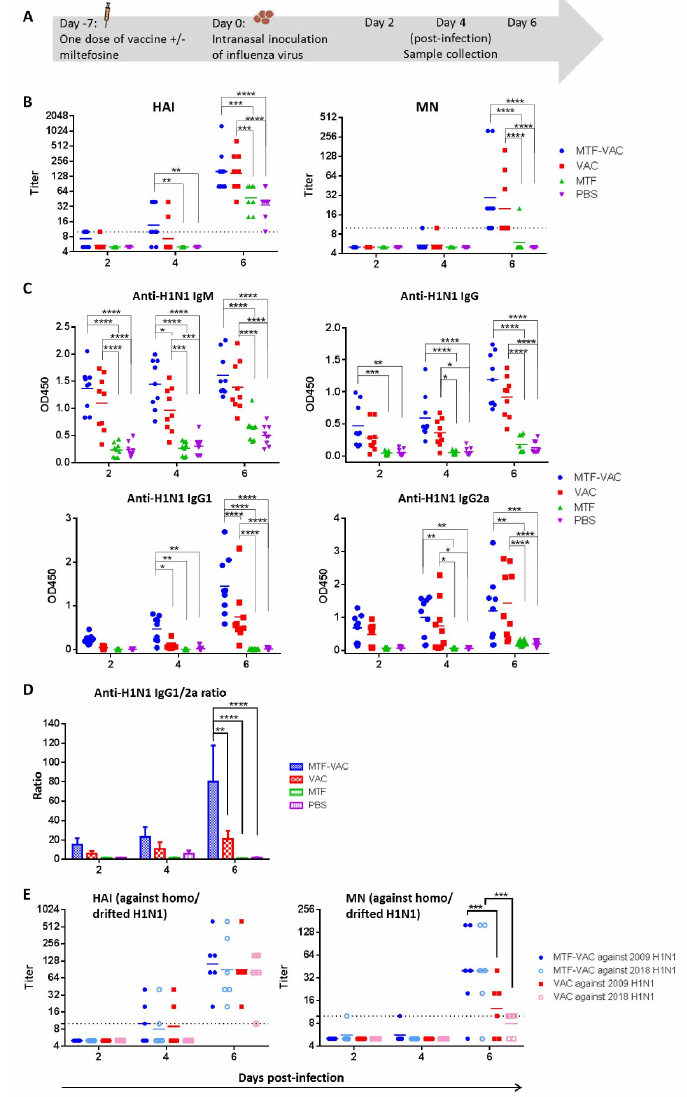
Figure 2. The effect of a single dose of vaccine with or without miltefosine on the antibody titers administrated 7 days before influenza virus challenge. ( A ) Schedule of influenza vaccination, virus challenge, and sample collection. ( B ) Hemagglutination inhibition assay (HAI) titers and micro-neutralization assay (MN) titers of serum samples post-infection. ( C ) Anti-H1N1 IgM, anti-H1N1 IgG, anti-H1N1 IgG1, and anti-H1N1 IgG2a antibody levels determined by ELISA. ( D ) Anti-H1N1 IgG1/G2a ratio. ( E ) HAI titers and MN titers of serum samples taken post-infection, assessed in vitro against homologous and antigenically-drifted H1N1 strains. MTF-VAC, miltefosine (0.2 mg) + vaccine group; VAC, vaccine only group; MTF, miltefosine (0.2 mg) only group; PBS, PBS only group. Short